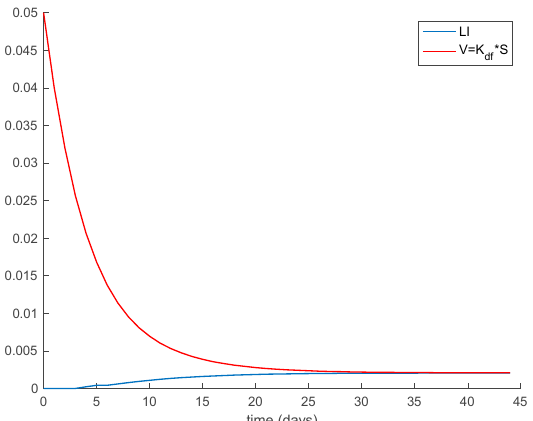
Figure 8. Satisfaction of Condition 3 from Theorem 1 in Case 1.4 conditions.